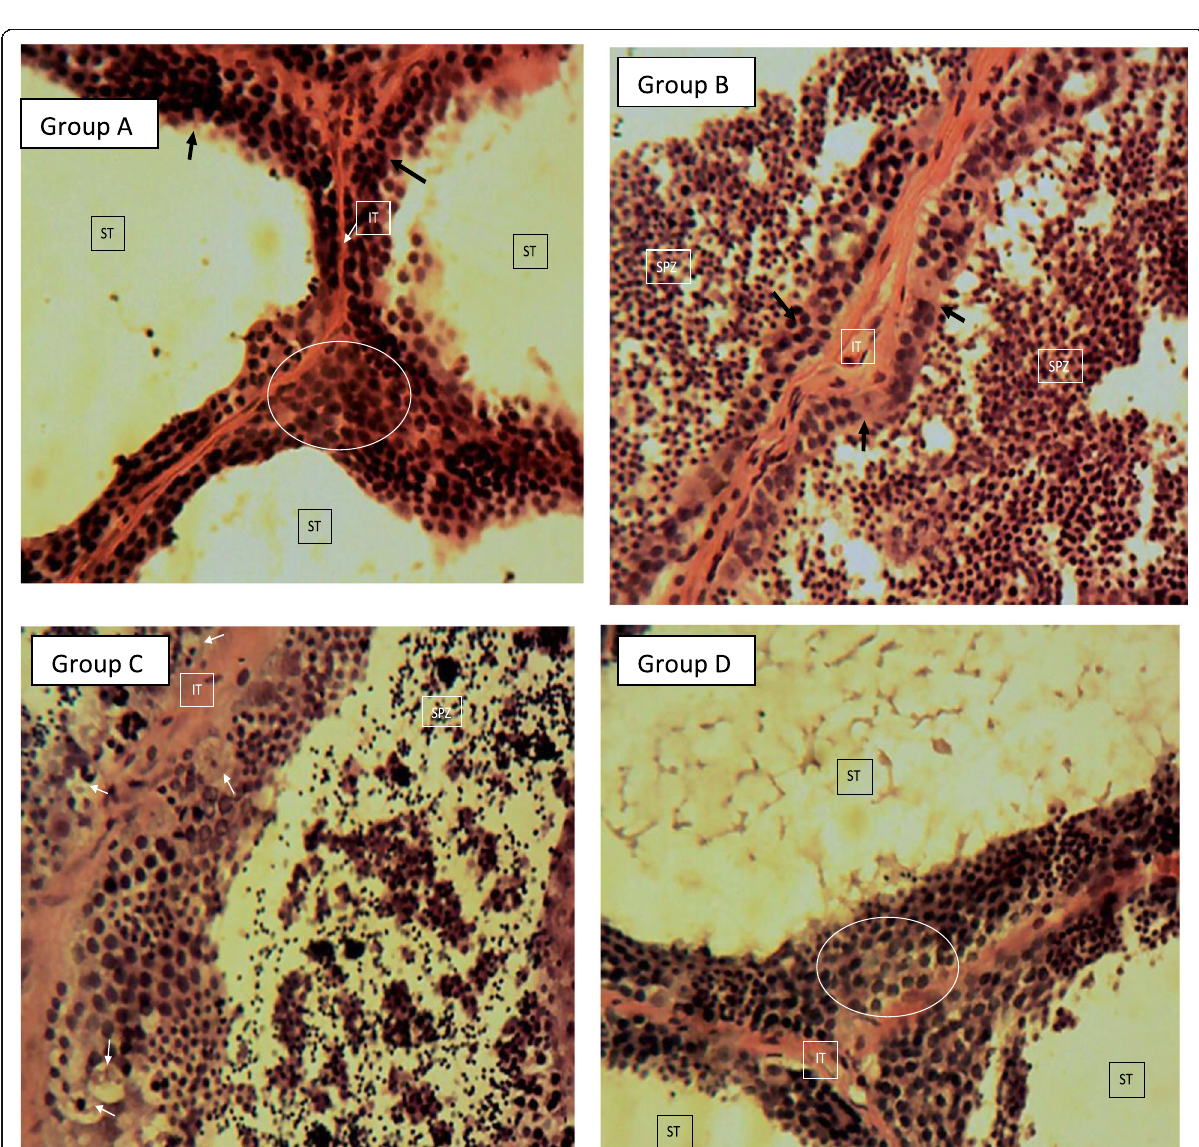
Fig. 3 Histopathology of the testes of C. gariepinus exposed to different concentration of lambda-cyhalothrin on 14 days. Group A (control) active spermatogenic stage (white circle) and abundant spermatogenic cells (black arrows), B (2.5 × 10 − 4 μ g/L), C (5.0 × 10 − 4 μ g/L), and D (6.25 × 10 − 4 μ g/L) (seminiferous tubule (ST), spermatocyst (white circle), testicular interstitium (IT), and spermatozoa (SPZ); H&E ×